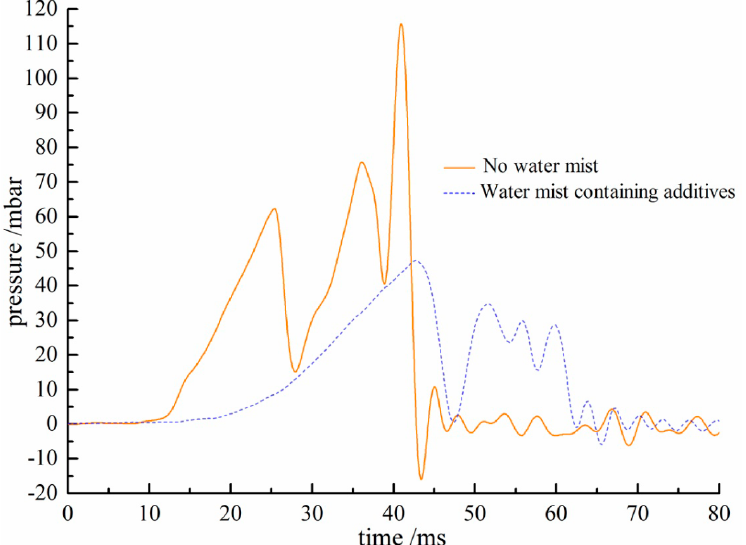
Figure 8. Combustion explosion pressure changes with time.